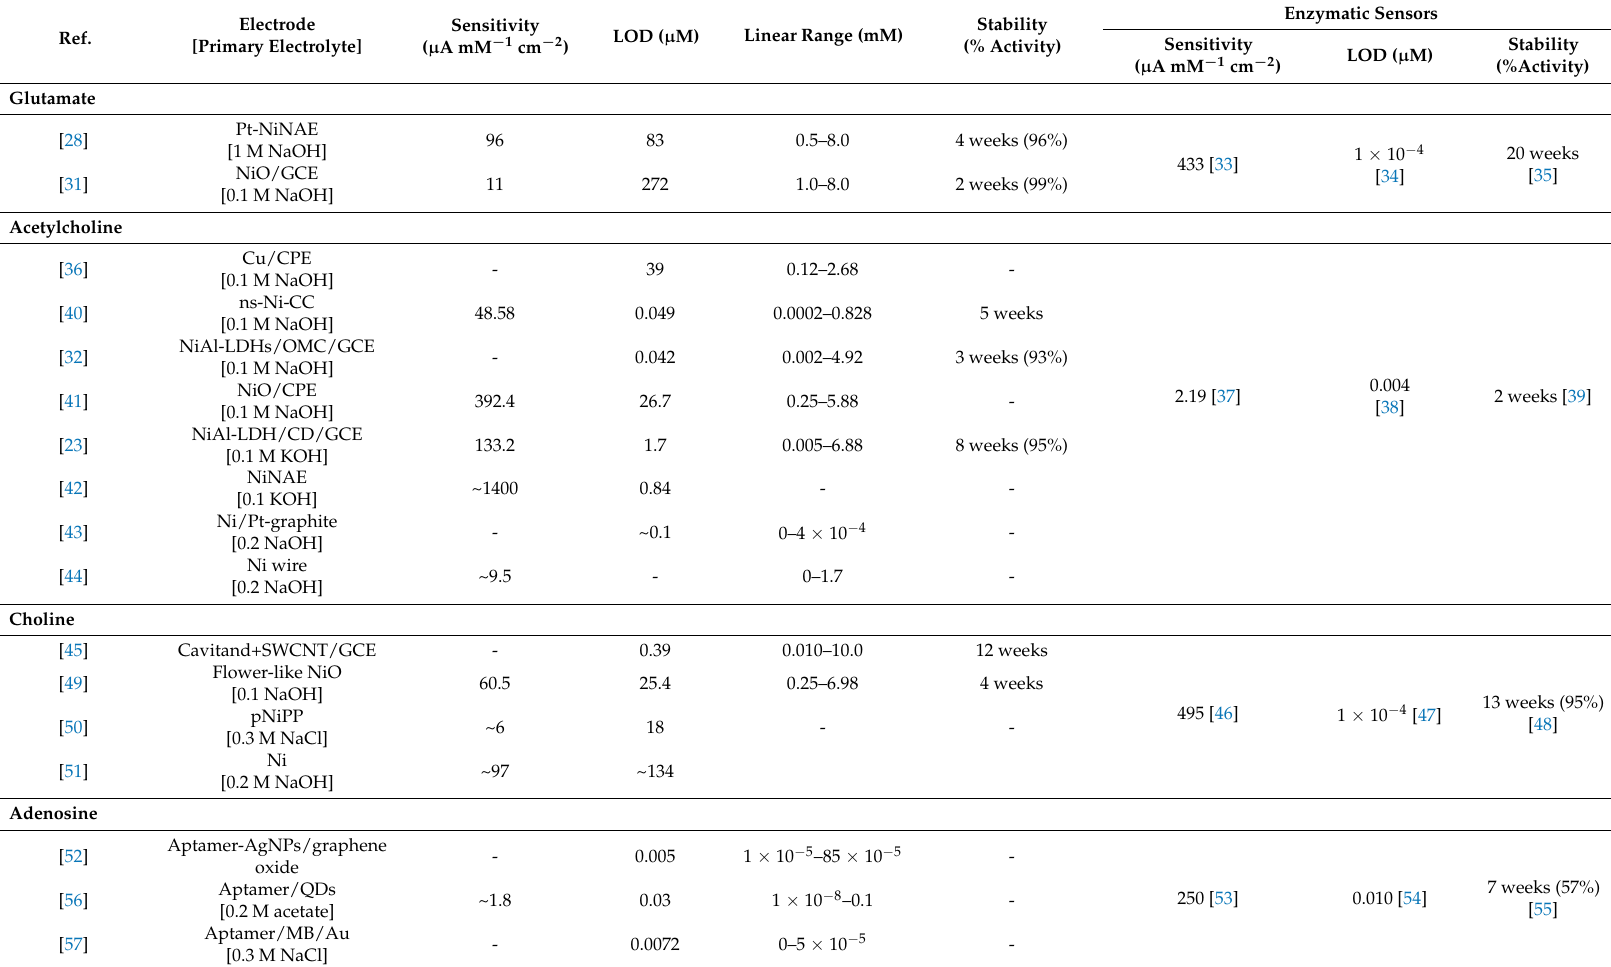
Table 1. Materials and performance of non-enzymatic electrochemical neurotransmitter biosensors